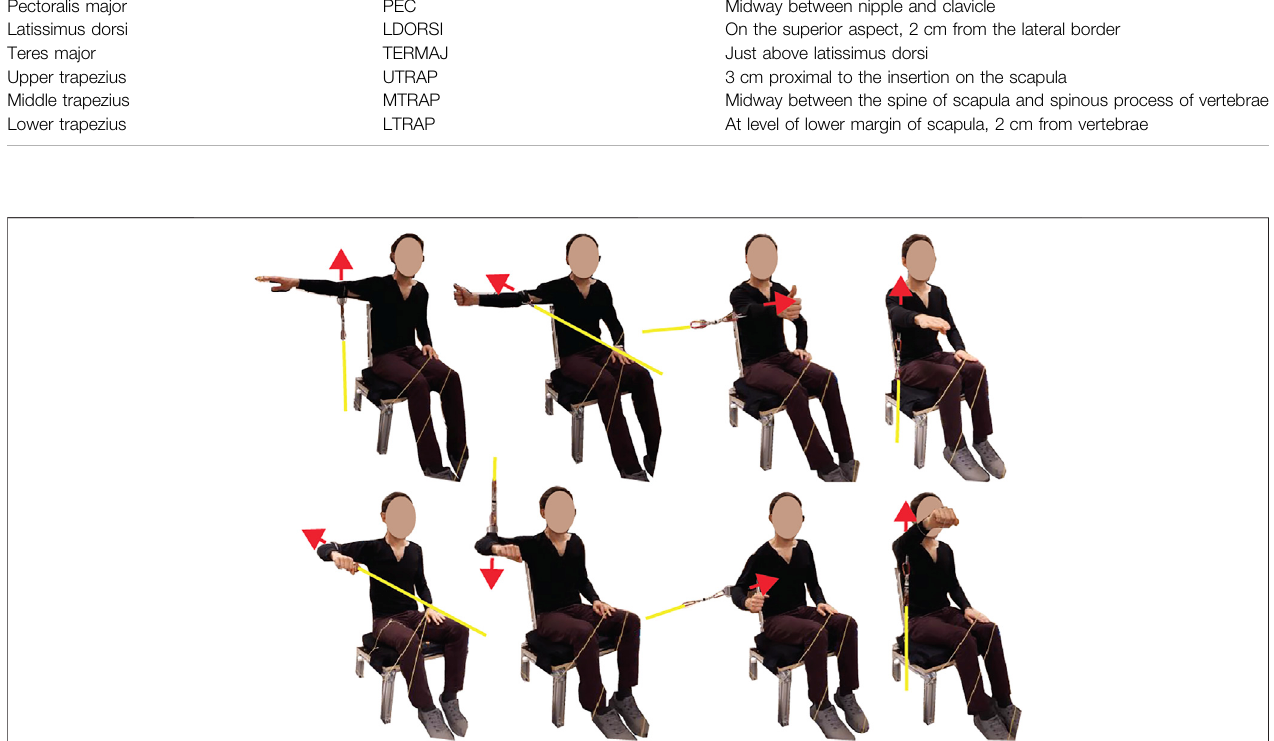
FIGURE1| Eightmaximumvoluntaryisometriccontraction(MVIC)directionswithyellowlinesrepresentingaropethatwasrigidly fi xedatoneendandattachedtoa cuffjustabovetheelbowattheotherend,withaloadcellinseries.Theredarrowsindicateacontractiondirection.TheMVICdirectionsstartingfromthetopleftwerearm abducted90 ° withpalm facing down, maximum abduction; arm abducted 90 ° thumb pointed up,maximum horizontal extension;arm fl exed90 ° with thethumb pointed up, maximum horizontal fl exion; arm fl exed 90 ° with palm facing down, maximum fl exion; arm abduction 90 ° with the elbow fl exed 90 ° and palm facing down, maximum horizontal extension; arm abducted 90 ° with the elbow fl exed 90 ° and palm facing down, maximum adduction; arm abducted 30 ° with the elbow fl exed 90 ° , maximum adduction; arm fl exed 125 ° with palm facing down, maximum fl exion.